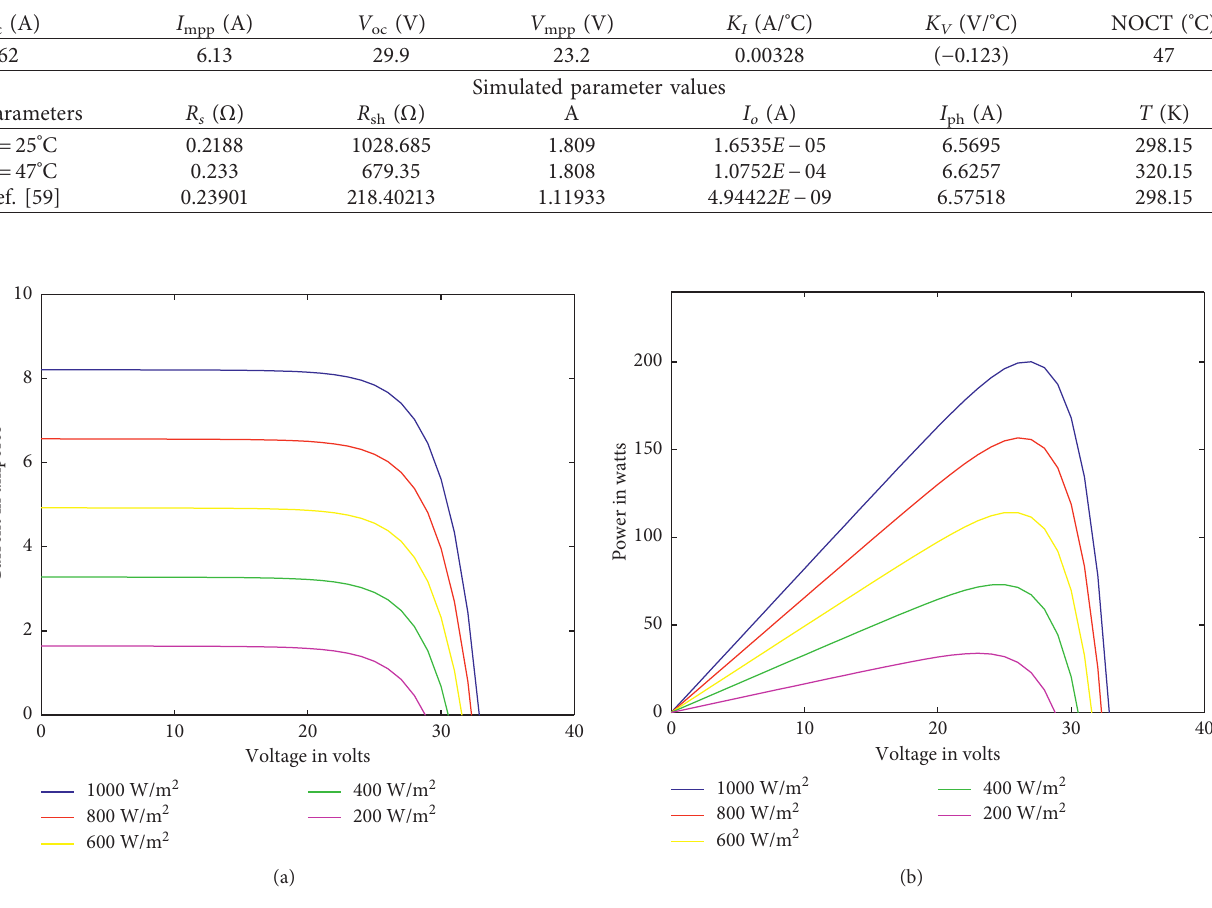
Figure 9: IV and PV curves for KC200GTshowing different irradiance values at 1000W/m 2 , 800W/m 2 , 600W/m 2 , 400W/m 2 , and 200W/m 2 ,